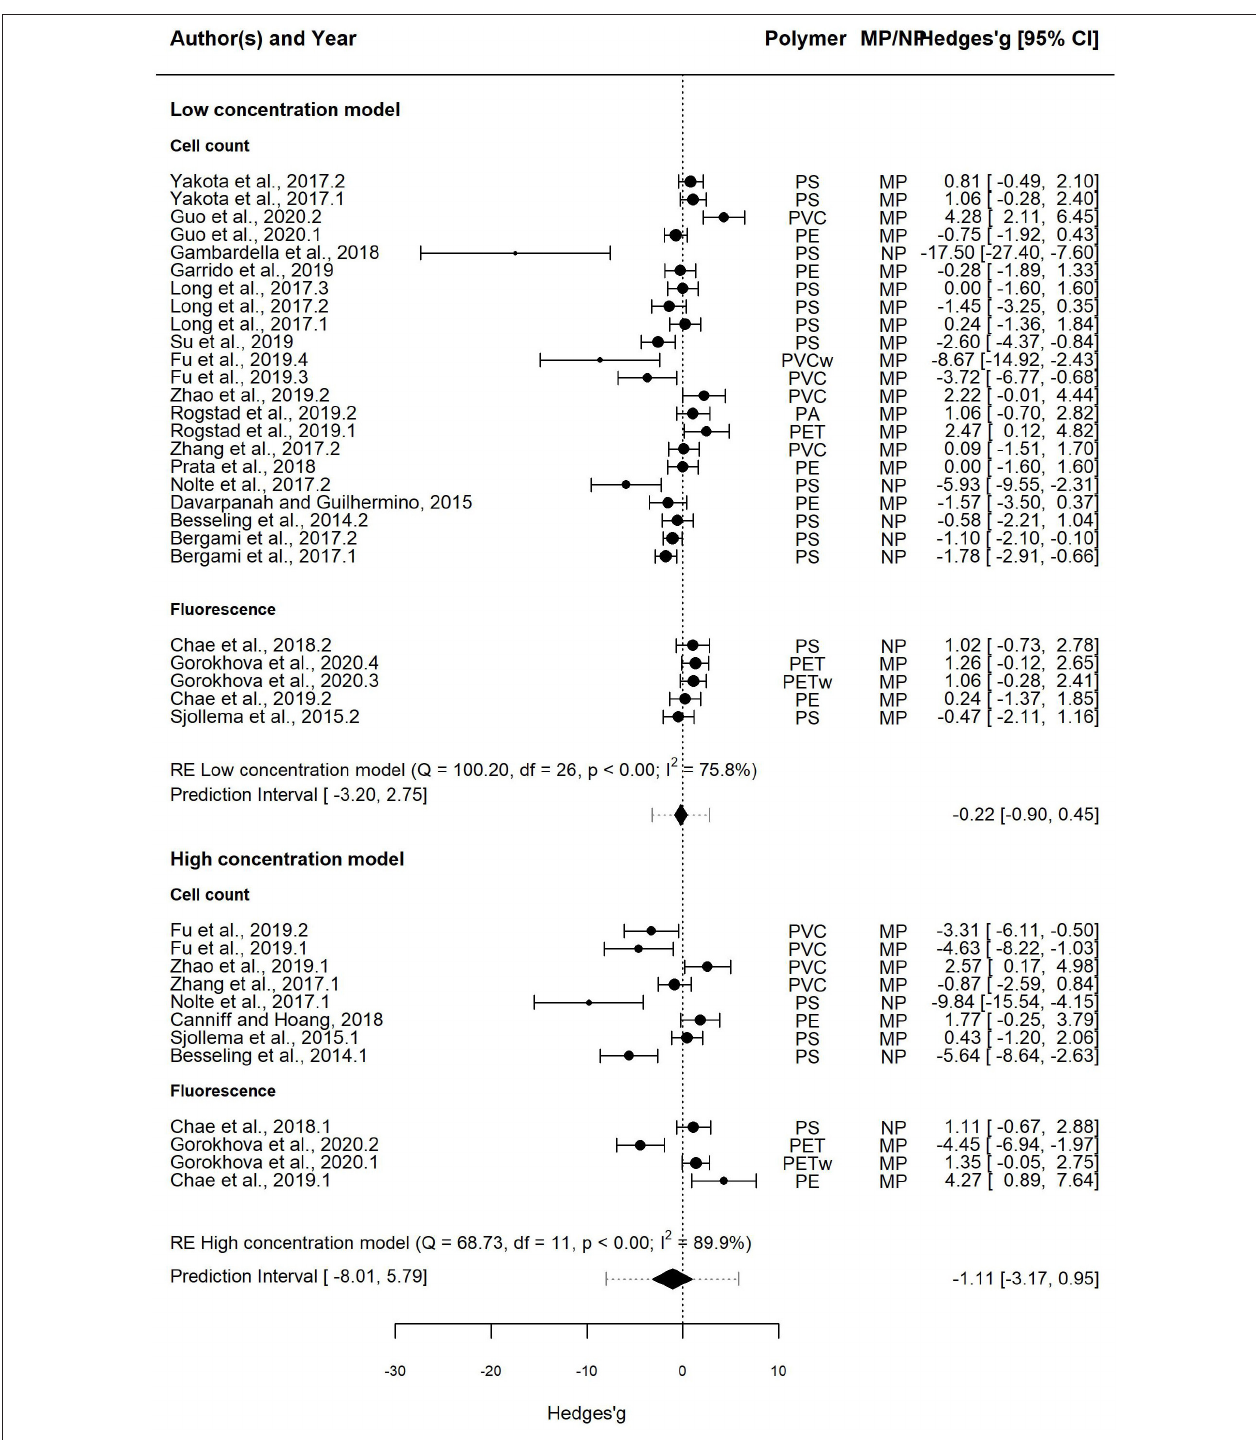
FIGURE 3 | Forest plot of the random-effect models for effect sizes estimated as Hedges’ g and the associated 95% confidence interval (95% CI) in the Low concentration model (upper panel; 20 entries) and the High concentration model (lower panel; 11 entries). The negative and positive values for Hedges’ g correspond to growth inhibition and stimulation, respectively. In each model, the overall effect (i.e., pooled estimate) is depicted as a diamond. The prediction interval shown by lines extending from the overall effect diamond captures the expected true effect for a future study. Symbol size is proportional to the study weight. Multiple entries for some studies correspond to independent trials for different polymers and/or different species. In each model, studies that employed cell count and fluorescence methods for measuring growth are shown separately.